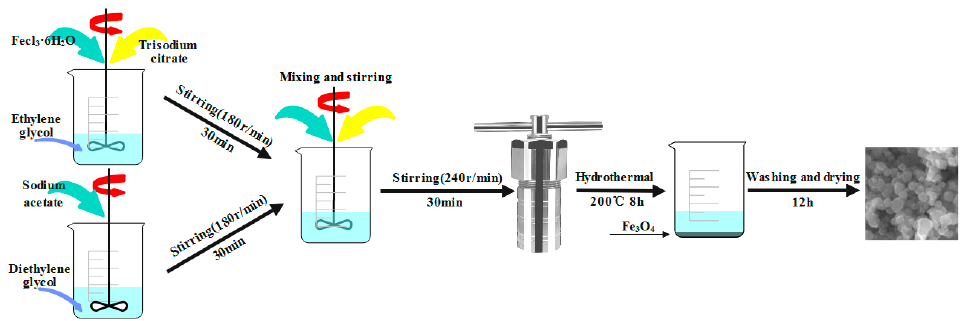
Figure 9. Production process of Fe 3 O 4.